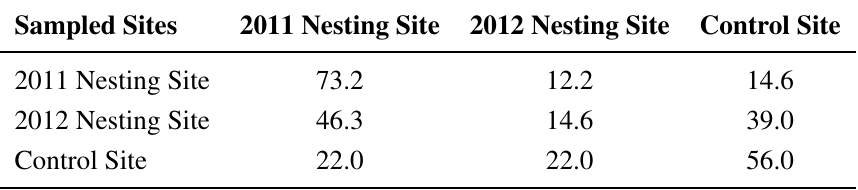
Table 2. Classification results of the discriminant model for the three sites (2011 Nest, 2012 Nest and Control Site) used by Socotra Cormorants in the